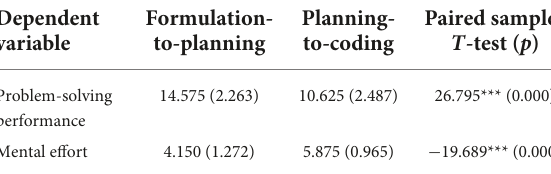
TABLE 2 Mental effort and problem-solving performance scores–mean (standard deviation) and paired samples t -test ( p